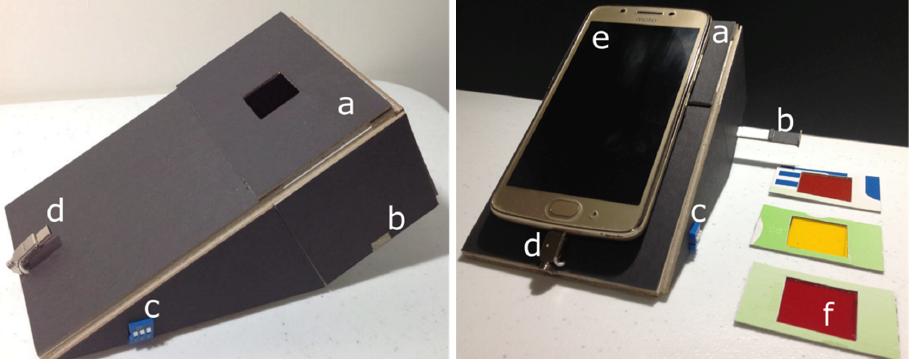
Figure 1. Pictures of the paper-based quantum dot (QD) reader. ( a ). External filter holder. ( b ). Tray to introduce the sample into the reader. ( c ). Illumination angle control. ( d ). Universal serial bus (USB) connector to power the excitation source. ( e ). Moto G5. ( f ). Paper-based filters.